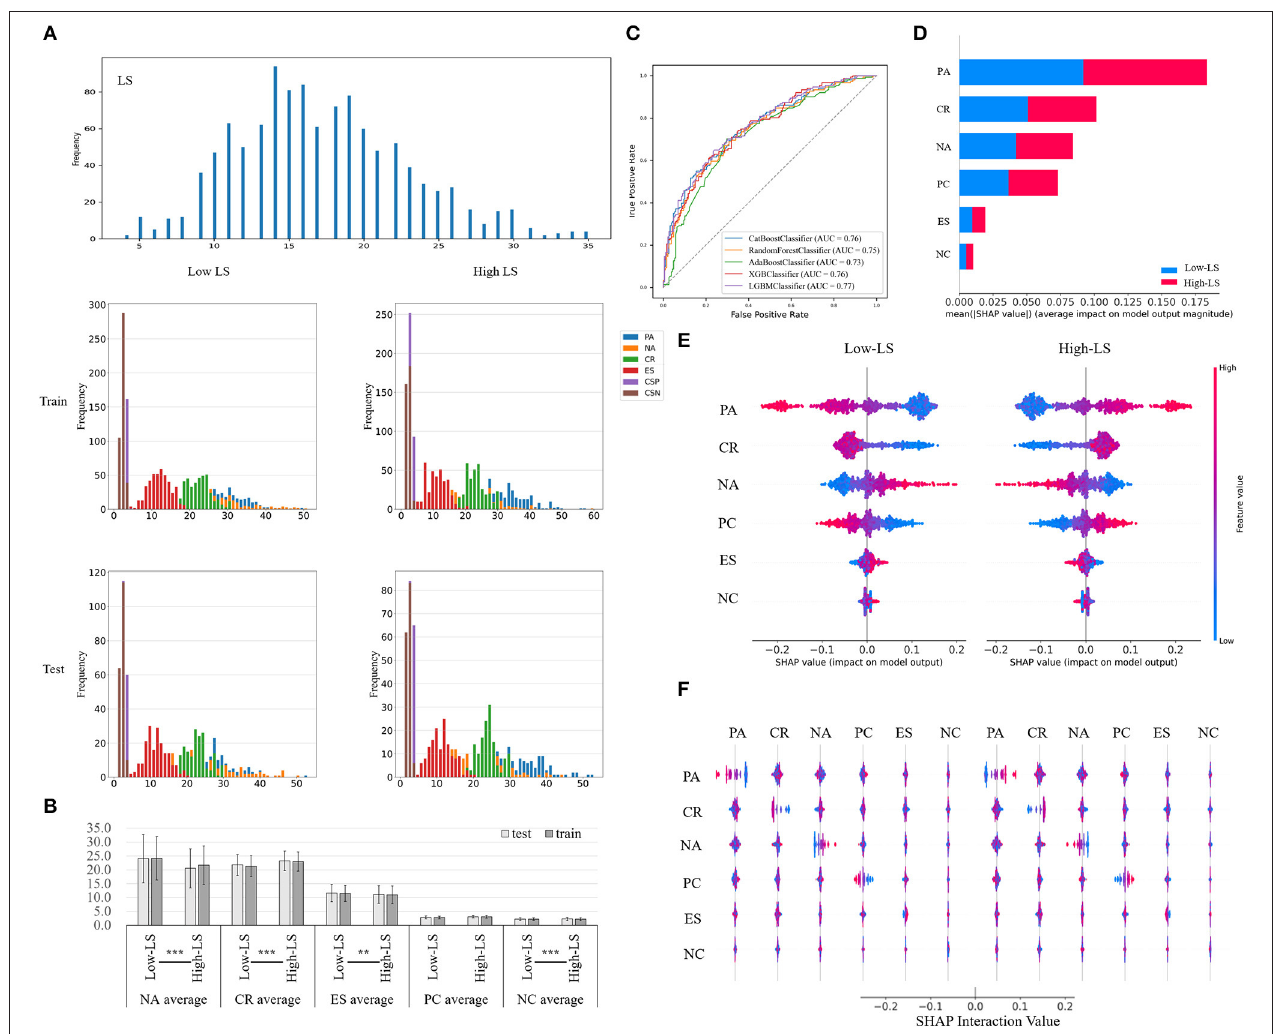
FIGURE 4 | (A) This figure shows the result of the distribution of each feature selected. (B) It shows the average value in each group of the datasets. ** p < 0.01, *** p < 0.001. (C) It shows the ROC curve and AUC of each model. (D) It shows the average impact of each feature within predicting two classes of LS. (E) The color and x -axis index the feature value and SHAP value, respectively, among two classes (low LS and high LS). (F) It shows the interaction of each variable among two classes (low LS and high LS). AUC, area under the curve; PC, positive coping; NC, negative coping; CR, cognitive reappraisal; ES, expression suppression; PA, positive affect; NA, negative affect; LS, life satisfaction; ROC, receiver operating